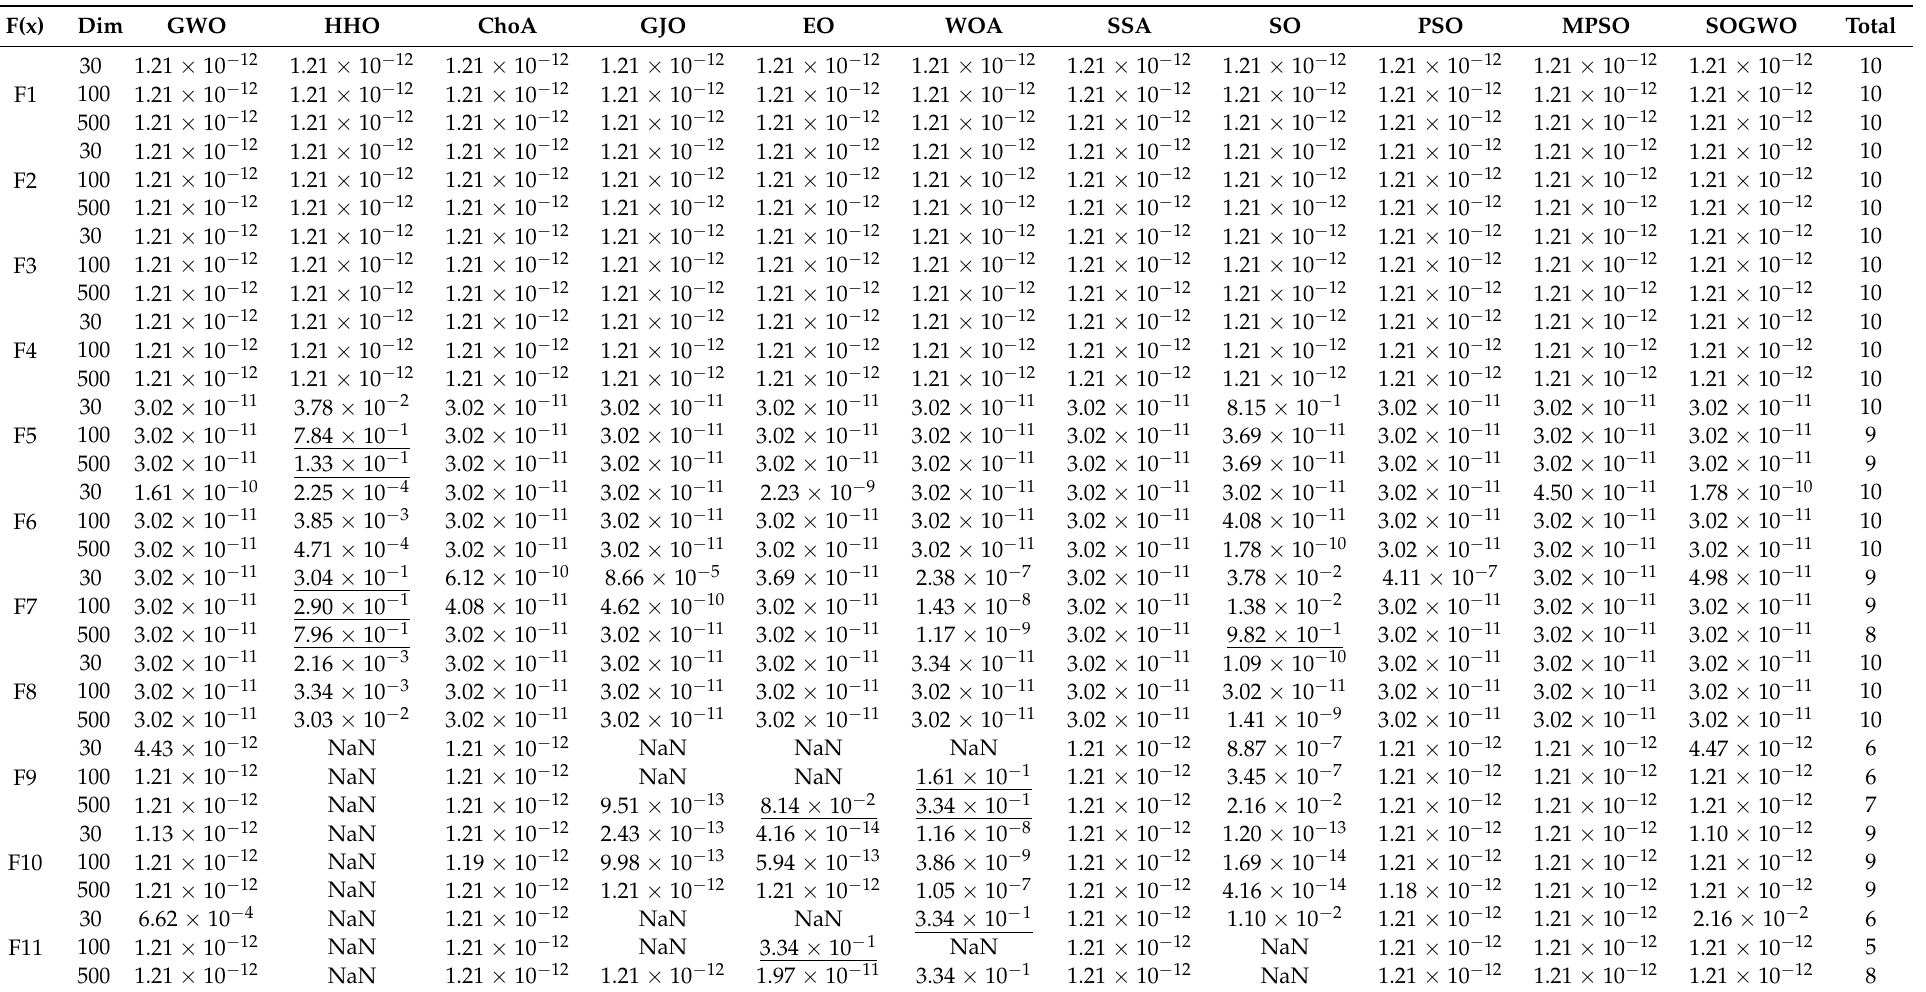
Table 6. Statistical analysis